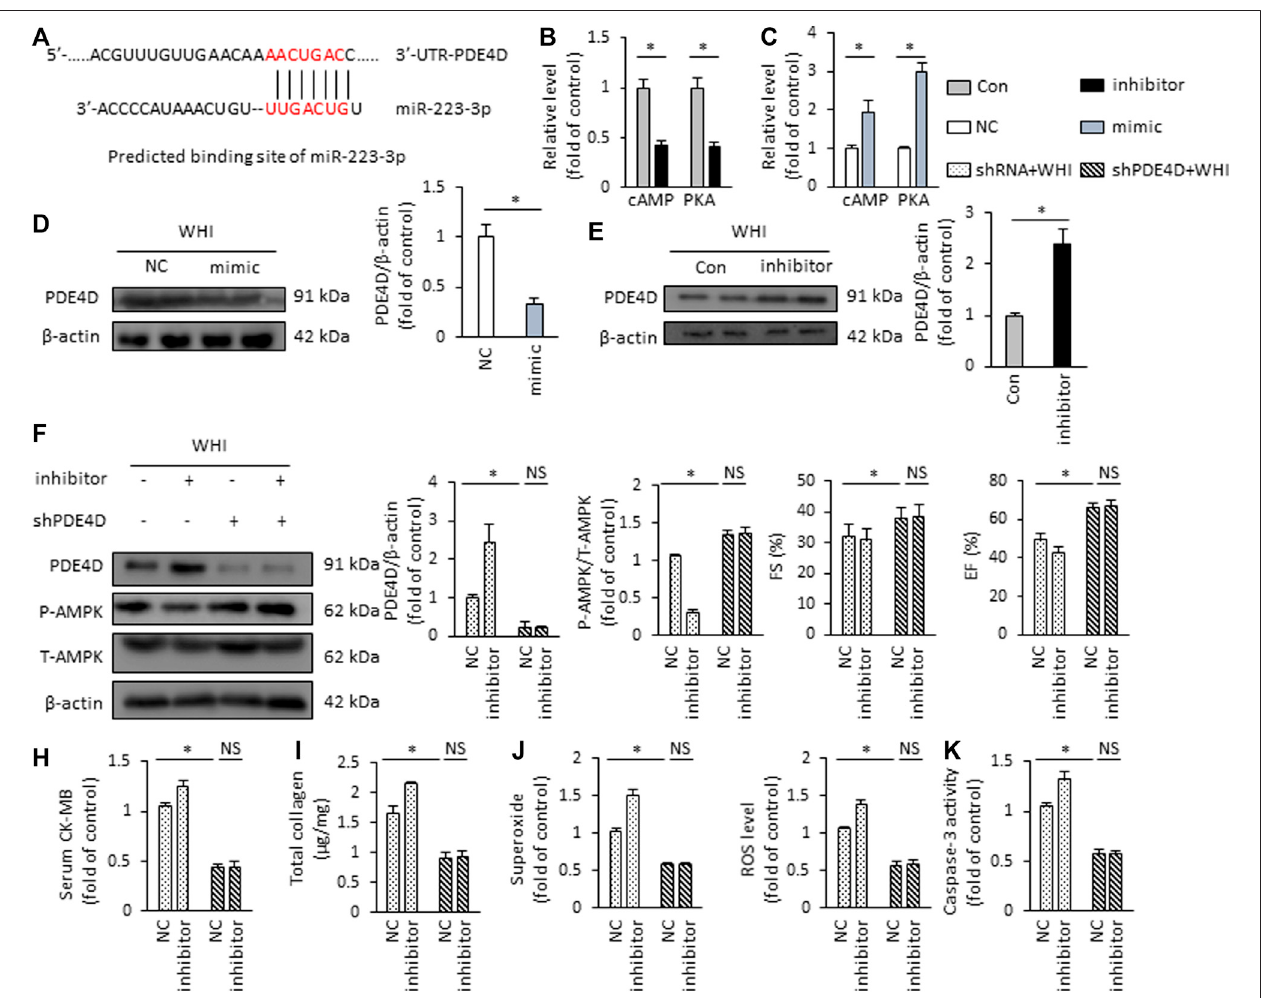
FIGURE7| miR-223-3p regulatesPDE4D/AMPKsignaling (A) Putativebinding siteofmiR-223-3pbyTargetScan Mouse7.1. (B , C) RelativecAMPlevelandPKA activityinthehearts( n (cid:2) 6). (D , E) ProteinexpressionofPDE4DdetectedbyWesternblot( n (cid:2) 6). (F) TheproteinexpressionalterationofPDE4DandAMPKinthehearts ( n (cid:2) 6). (G) The alteration in FS and EF in mice ( n (cid:2) 6). (H) Serum CK-MB level detected byELISA kit ( n (cid:2) 6). (I) Total collagen content in the mice hearts ( n (cid:2) 6). (J) ROS content in the hearts ( n (cid:2) 6). (K) Quantitative results of caspase-3 activity ( n (cid:2) 6). All data are presented as means ± SD. * p < 0.05 vs. the matched group.